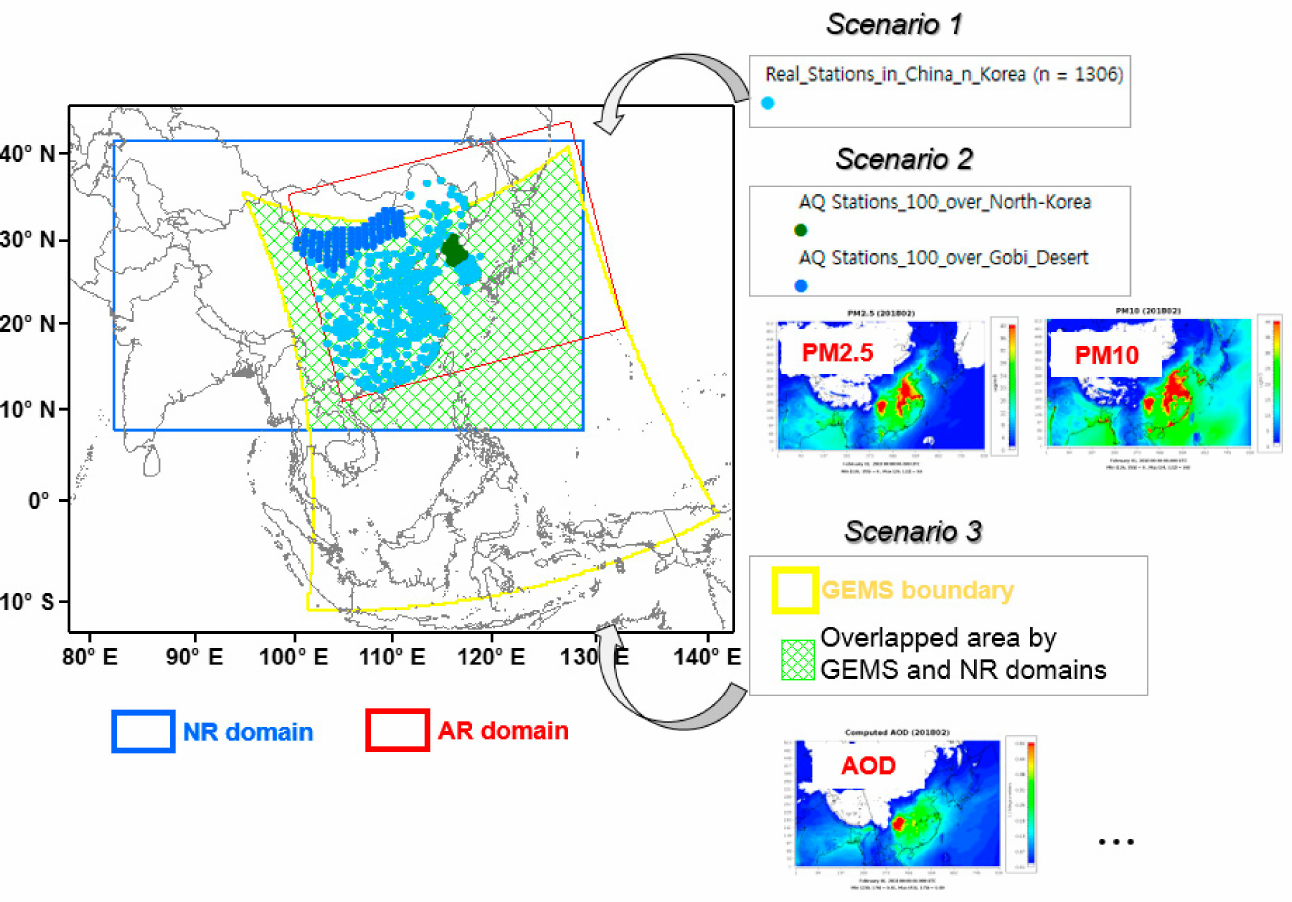
Figure 3. The schematic of the OSSE